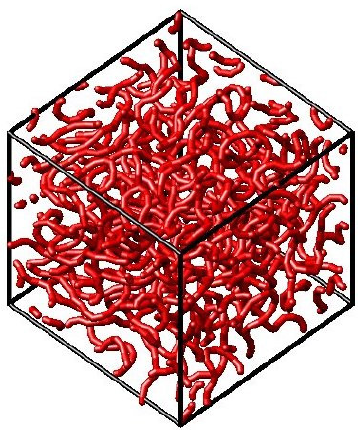
Figure 6. Illustration of an exemplary three-dimensional simulation volume with 200 polymer chains consisting of 200 monomers each.